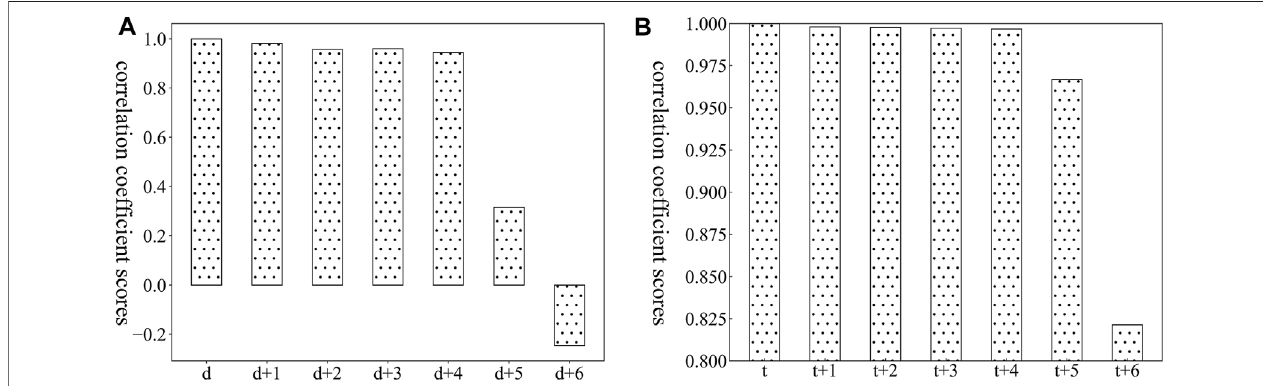
FIGURE 2 | Load correlation of adjacent time to d (day) and t (time). (A) shows the Pearson correlation analysis results of adjacent daily loads, and (B) shows the Pearson correlation analysis results of the load at adjacent